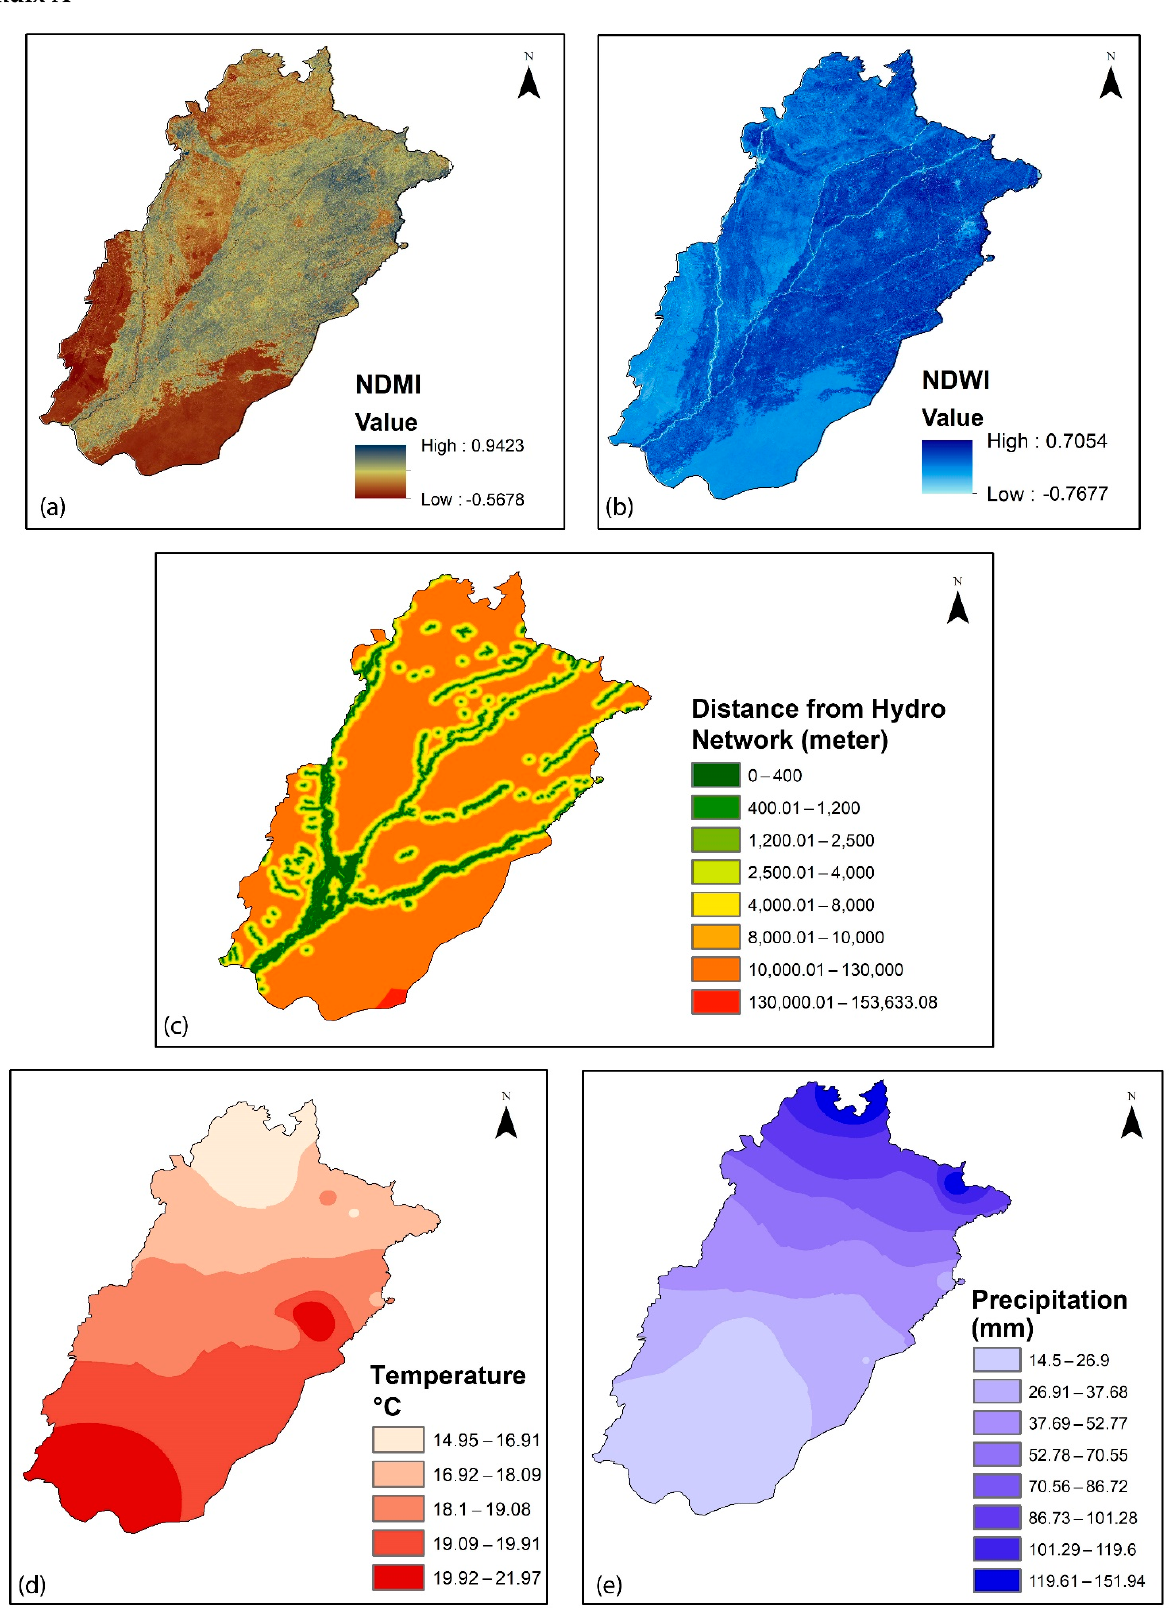
Figure A1. Maps of indicators belonging to hydrometeorology group (G1): ( a ) normalized difference moisture index; ( b ) normalized difference water index; ( c ) distance from hydrological network; ( d ) temperature; ( e ) precipitation.